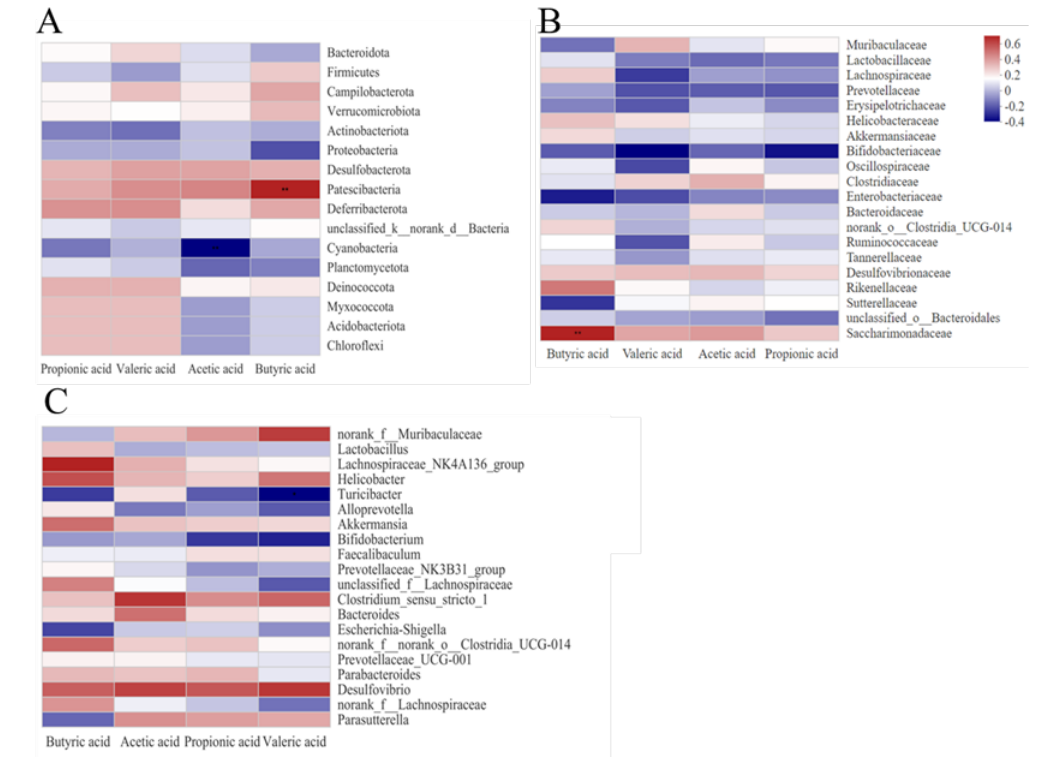
Figure 6. Cluster heat map for correlation analysis of acetic acid, propionic acid, butyric acid, and valeric acid with gut microbiota in mouse colonic contents. ( A ) Cluster heat map for the correlation analysis of acetic acid, propionic acid, butyric acid, and valeric acid with gut flora at the phylum level. ( B ) Cluster heat map for correlation analysis of acetic acid, propionic acid, butyric acid, and valeric acid with gut microbiota at the family level. ( C ) Cluster heat map of correlation analysis of acetic acid, propionic acid, butyric acid, and valeric acid with gut microbiota at the genus level. Note: red represents a positive correlation, blue represents a negative correlation, ** p < 0.01. Note: PF represents the pair – fed control group. AF represents the alcohol – fed model group. PC represents the positive control group. LH represents the low – dose citrus honey group. MH represents the medium – dose citrus honey group. HH represents the high – dose citrus honey group. FG represents the fructose syrup group.